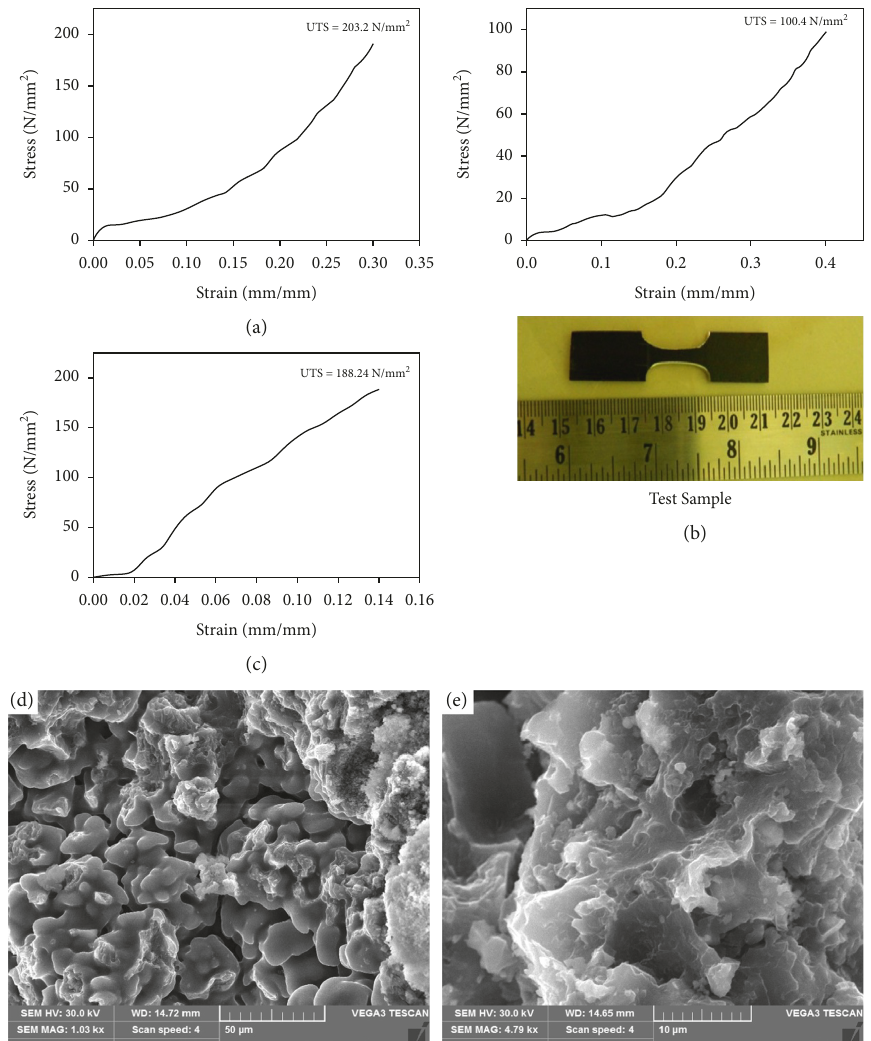
Figure 9: Tensile properties of (a) Mg CED coated, (b) Al powder coating, and (c) as cast AZ91D, and (d) fracture mode Al powder coating and (e) Fracture mode CED by epoxy.